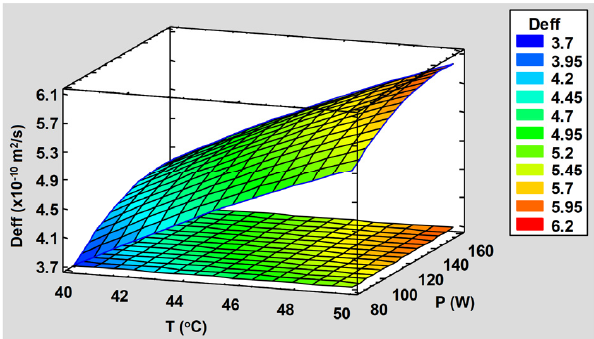
Figure 14. Effect of T and P on moisture diffusion coefficient Deff.